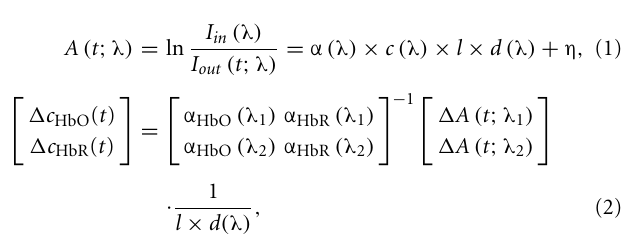
Frontiers in Human